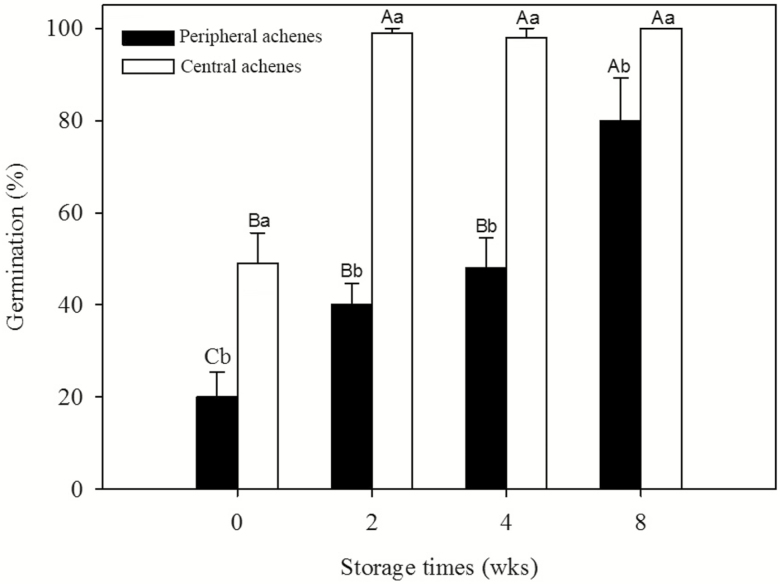
Effect of dry storage on germination percentage (mean ± SE) of freshly matured dimorphic achenes of Bidens pilosa. The letters indicating significance are based on Tukey’s HSD after ANOVA. Different uppercase and lowercase letters indicate significant differences between different dry storage time and central and peripheral achenes within each dry storage time, respectively (5 % level).